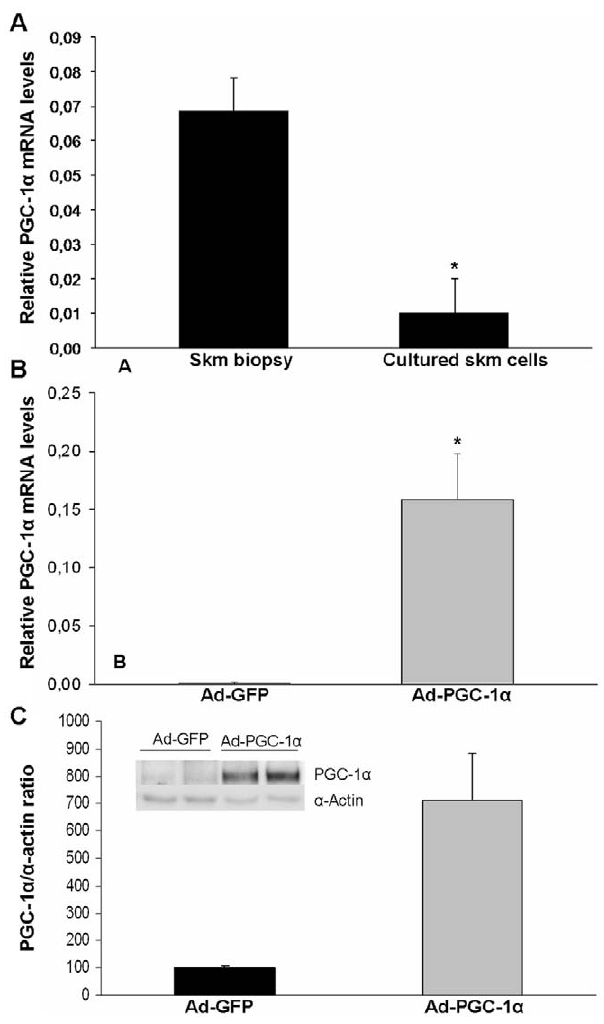
Figure 1. PGC-1 a gene expression. (A,B) Human PGC-1 a mRNA levels were determined relative to B2M using RT and real-time PCR. (A) Six samples were analyzed, three from cultured skm cells and three from skm biopsies. Data are expressed as mean values 6 SEM of 2 2 D Ct . The significance of the difference is *p , 0.05. (B) Cultured skm cells were transduced with Ad-GFP or Ad-PGC-1 a . Data are expressed as mean values 6 SEM of 2 2 D Ct for three experiments performed in triplicate. The significance of the difference is *p , 0.001. (C) Cultured skm cells were transduced with Ad-GFP or Ad-PGC-1 a . Immunoblot analyses were performed on nuclear cell extracts (30 m g protein) and membranes were hybridized with antibodies against PGC-1 a and a - actin. A representative image is shown. Bands were quantified with ImageQuant LAS 4000. Data are means 6 SEM from two experiments performed in triplicate. Significance of differences versus cells treated with Ad-GFP: *p , 0.05.